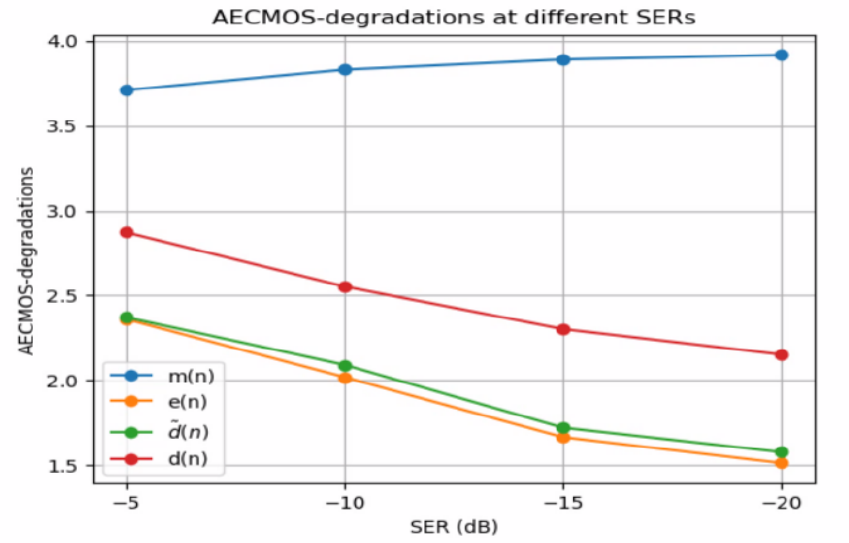
Figure 5. AECMOS-degradations of the different signals at various signal-to-echo ratios